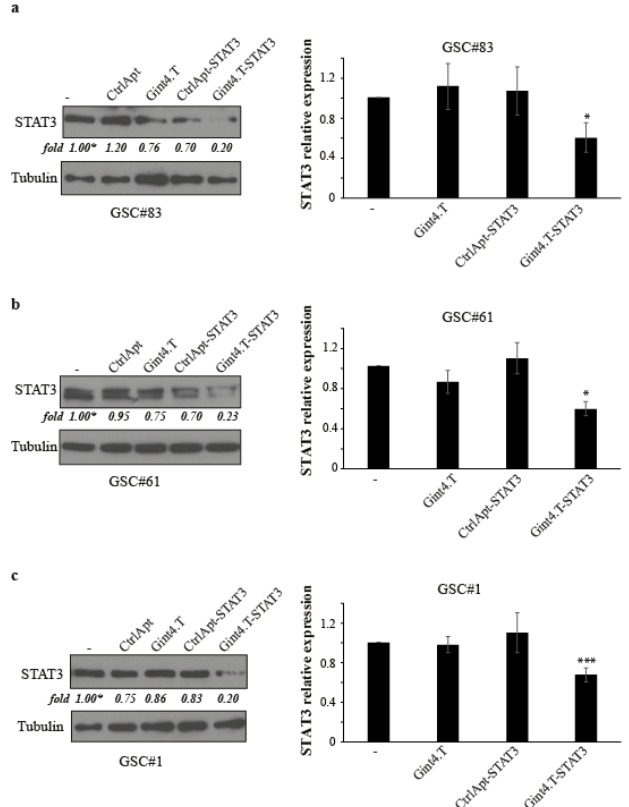
Figure 1. Gint4.T-mediated delivery of STAT3 siRNA in primary GSCs. ( a – c ) Primary GSCs (PDGFR β + ) were treated with 400 nmol / L Gint4.T, Gint4.T-STAT3, control aptamer (CtrlApt), or control chimera (CtrlApt-STAT3) as indicated. After 72 h, the STAT3 protein (left panels) or mRNA (right panels) levels were analysed by immunoblotting or RT-qPCR, respectively. Anti-tubulin antibody was used as an immunoblot loading control. Values below the blots indicate quantization relative to the untreated (“ − ”) sample, labelled with an asterisk normalized on the loading control signals. Error bars